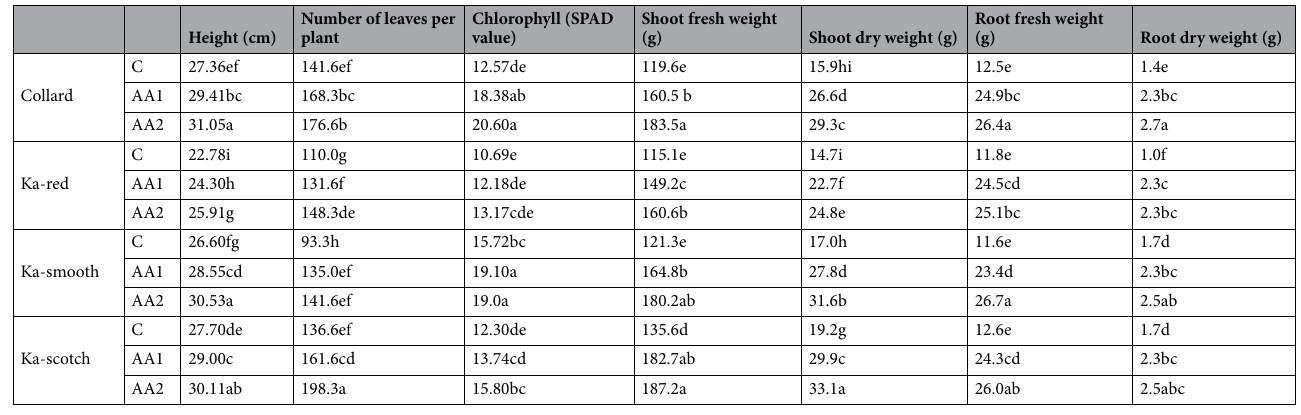
Table 2. Interaction effect of cabbage cultivar and amino acid application on growth parameters. Control control treatment, AA1 150 mg/L of amino acid, AA2 150 and 300 mg/L of amino acid. According to the least significant difference test, a column in each treatment and means followed by the same letter is not significantly different at P < 0.05.